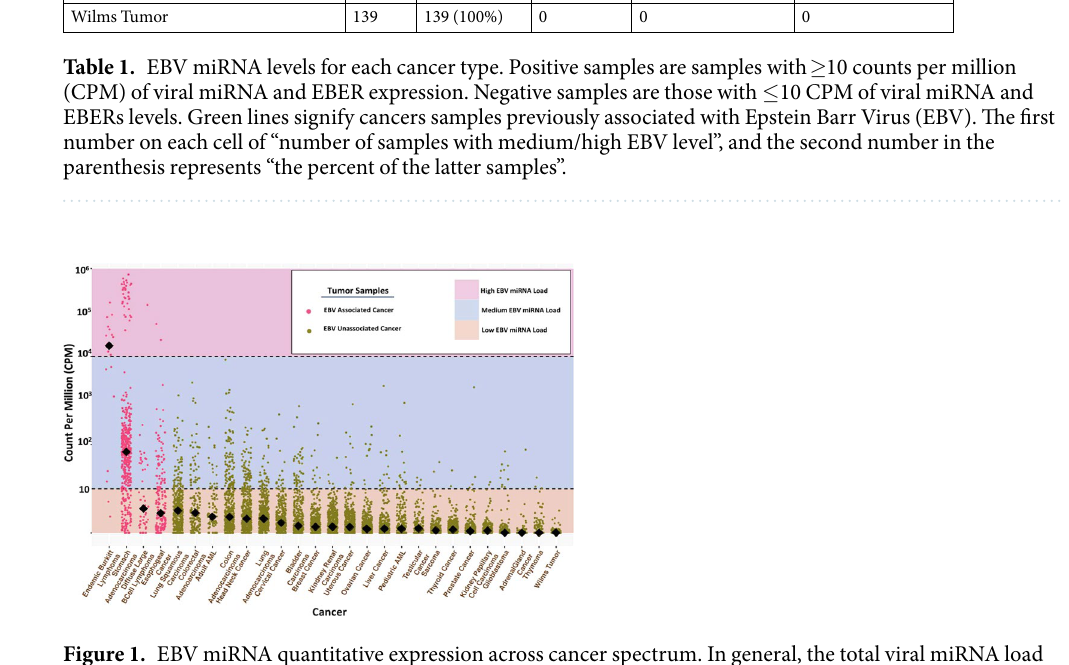
Figure 1. EBV miRNA quantitative expression across cancer spectrum. In general, the total viral miRNA load at the highest levels ( ≥ 10 4 CPM) were observed only in tumors previously associated with harboring the virus (pink/purple), which correlate with reported proportions of viral positive tumors in the literature. Previously unassociated tumors (green) posses viral miRNA levels only at intermediate (10 1 –10 4 CPM) or low ( < 10 1 CPM) levels. Gastric tumors were interesting in that a majority (69.5%) fall within in the medium category suggesting an association with EBV beyond simple viral infection of the tumor in the 10% at high levels. The y-axis represents log10 counts of viral miRNA per total human and viral miRNA aligned to their respective genomes. The dashed lines separate the defined categories of viral miRNAs based on designated expression levels and and diamond lines denote median expression